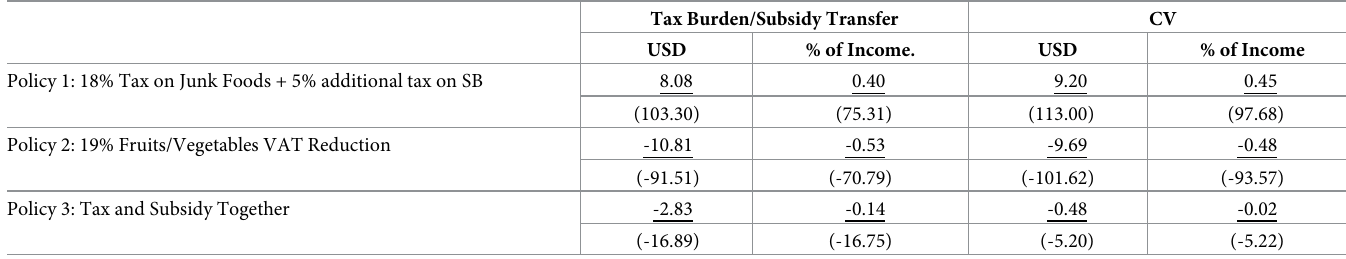
Table 5. Estimated Compensating Variation (CV) and tax burden/subsidy transfer assuming a 100% pass-through of taxes/subsidies in prices, all households.